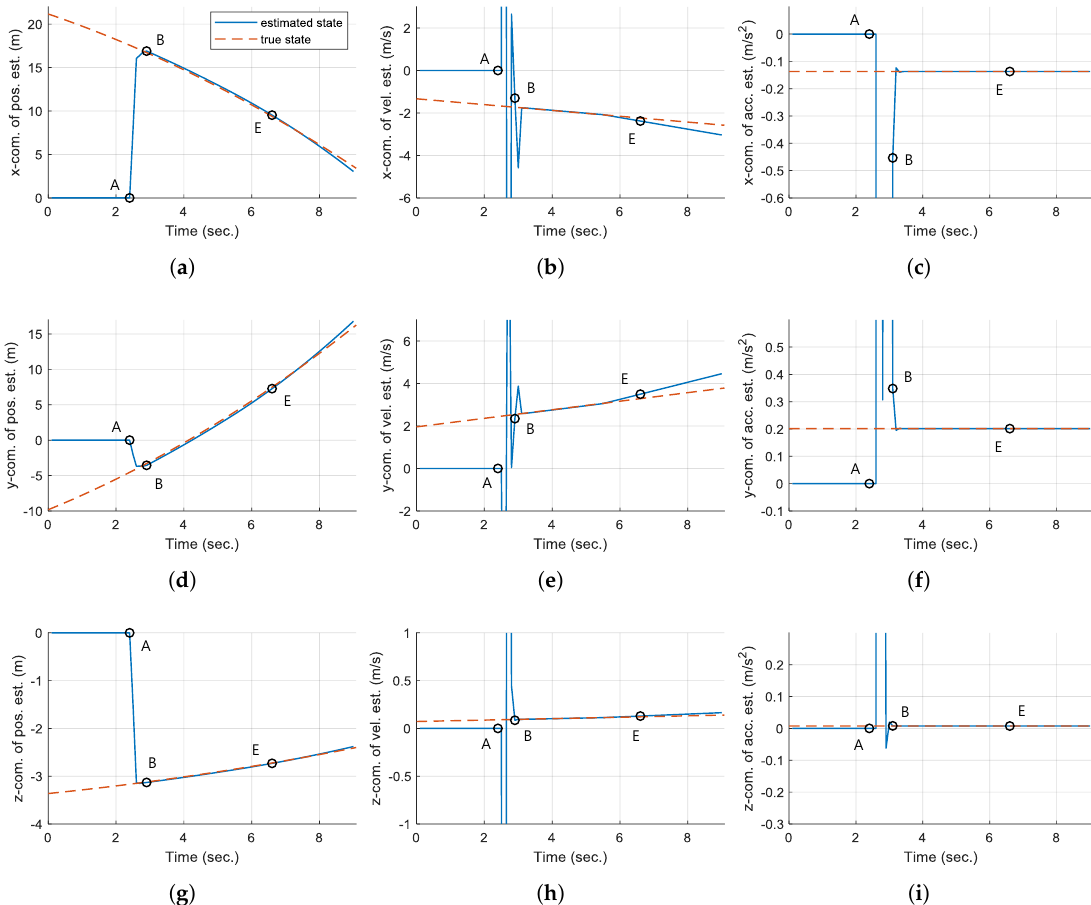
Figure 11. Time histories of the state estimate (Simulation II): ( a ) x n ( f ) ¨ y n , ( g ) z n , ( h ) ˙ z n , and ( i ) ¨ z n e , k e , k e , k